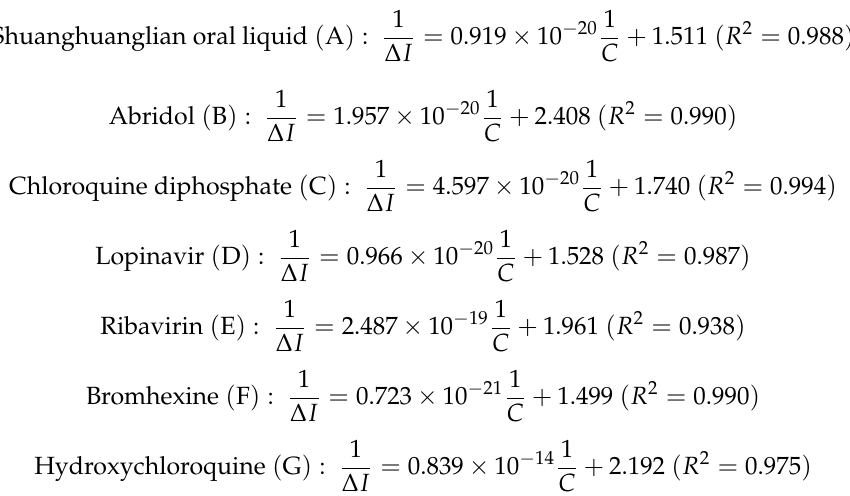
Table 1. The affinity values of the optimal spike protein/lopinavir binding conformation. Mode